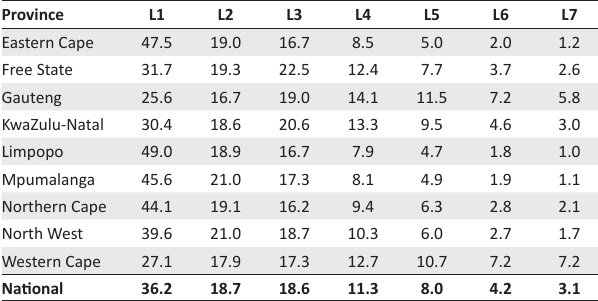
TABLE 2: Percentage of Grade 6 learners by achievement level in mathematics.